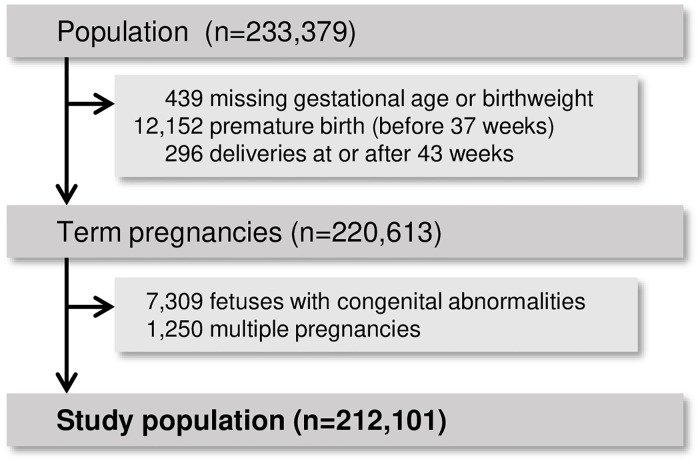
Study population (exclusion criteria are not mutually exclusive).